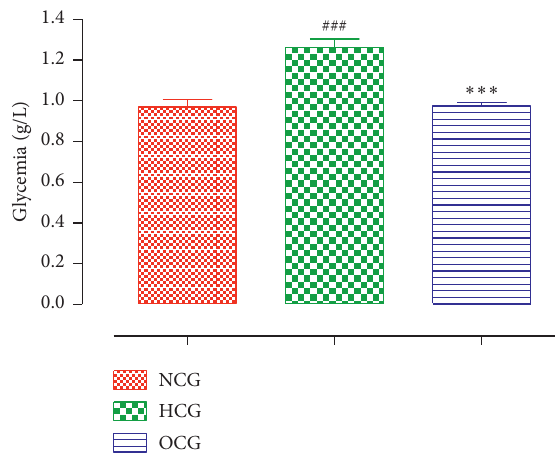
Figure 4: Effect of the ODSO on the glucose level. The values are presented in mean ± SEM. n � 6–10; ### P < 0 . 001 compared to the control group; ∗∗∗ P < 0 . 001 compared to the Allx control